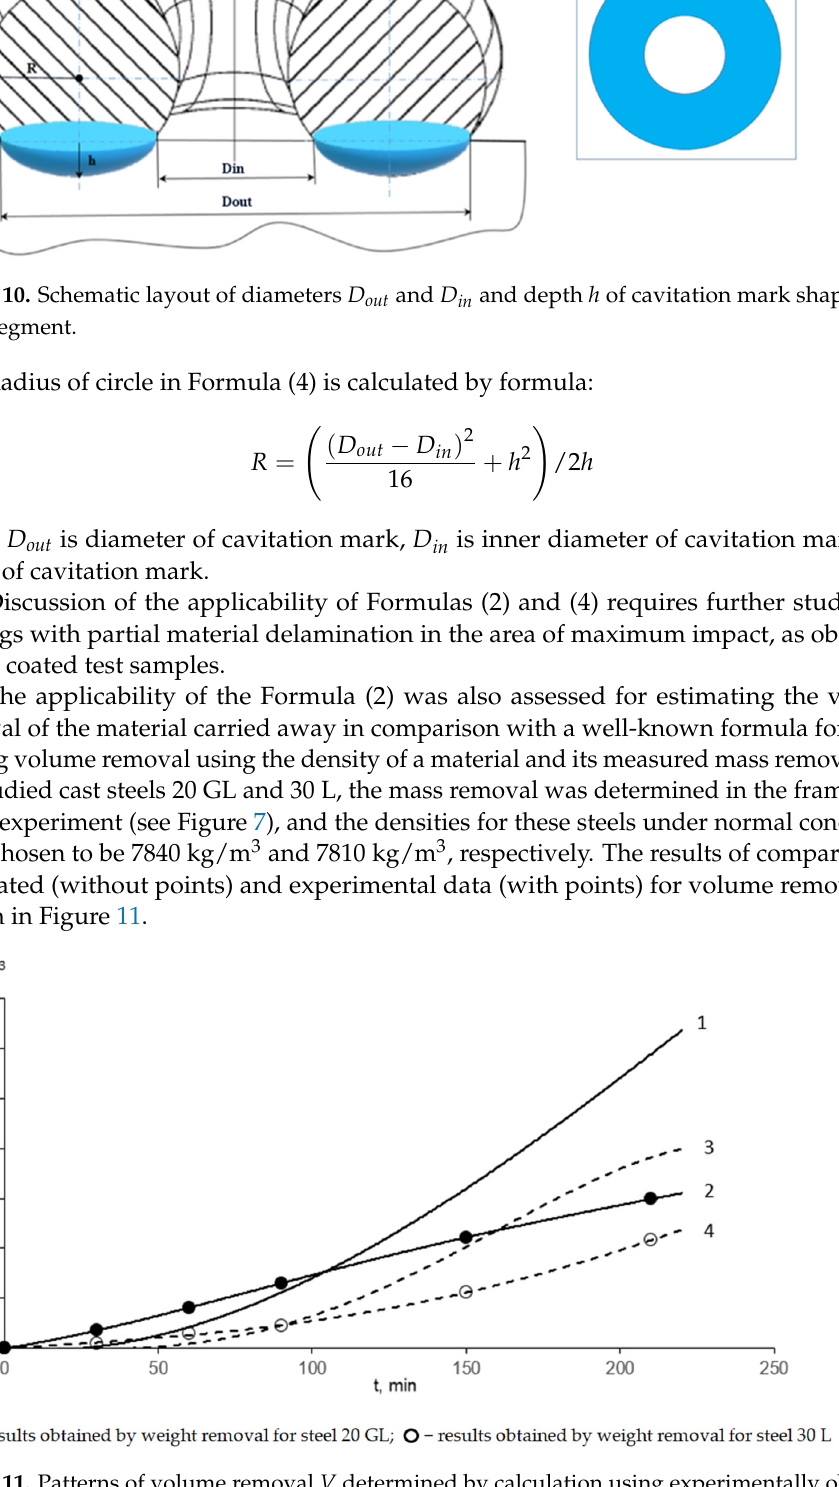
Figure 11. Patterns of volume removal V determined by calculation using experimentally obtained weight removal (2, 4) and by the formula for a volume removal in the form of a spherical segment using the parameters of the surface profiles (1, 3) for steels 20 GL and 30 L, respectively, during cavitation tests.